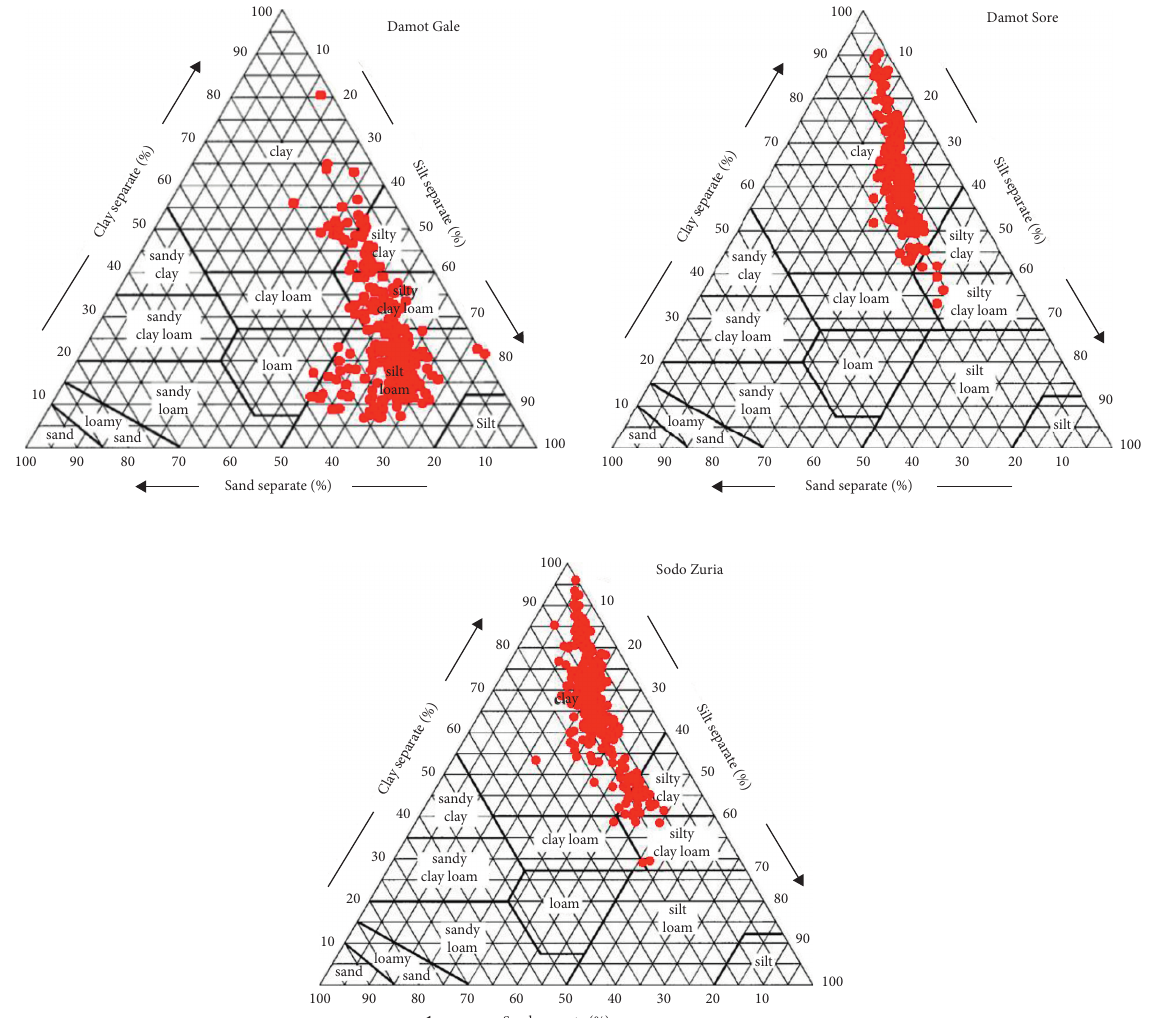
Figure 5: Soil textural classes of the study districts in